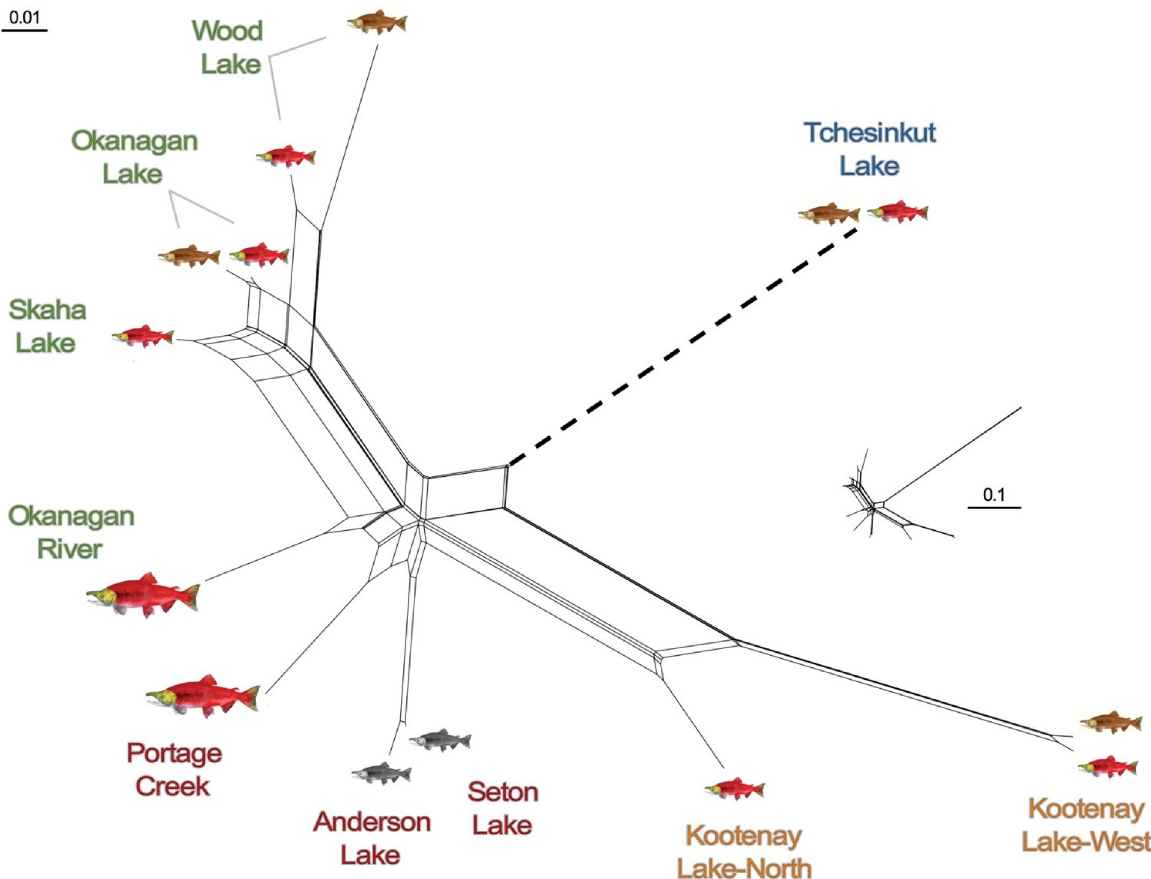
Fig 2. Two-dimensional NeighbourNet (Bryant and Moulton 2004) population network based on Weir and Cockerham’s (1984) unbiased estimates of pairwise genetic differentiation ( θ ) calculated using genotypic data at 6,234 neutral SNPs. Length of the Tchesinkut Lake branch is shortened for better comparison of other branches (relative length of the whole network is shown inset). Oncorhynchus nerka images and population text color are as depicted in Fig 1. This figure was modified from